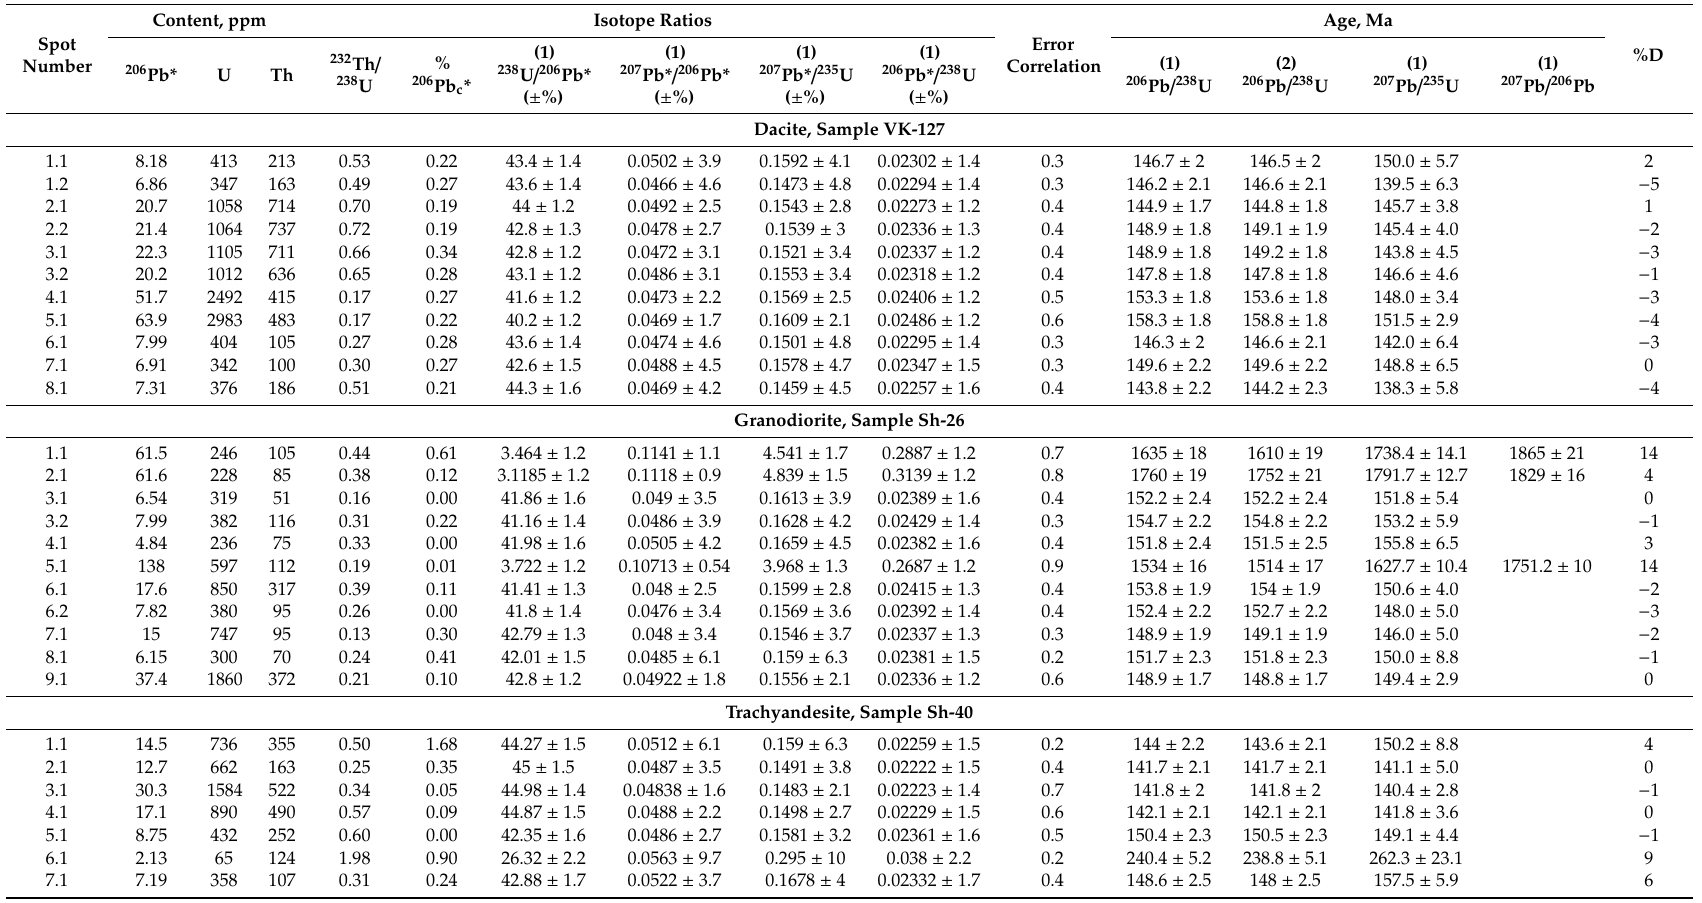
Table 5. Results of U–Th–Pb isotope investigations of zircons (SHRIMP-II SIMS) from dikes at the Vyun and Shumniy